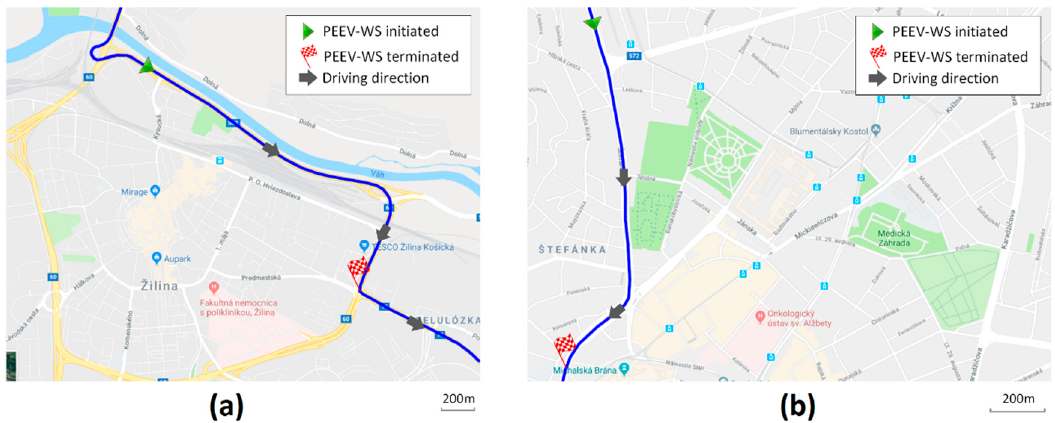
Figure 5. The road network with highlighted emergency routes (in blue): ( a ) Žilina—highway-like scenario; ( b ) Bratislava—dense urban scenario.